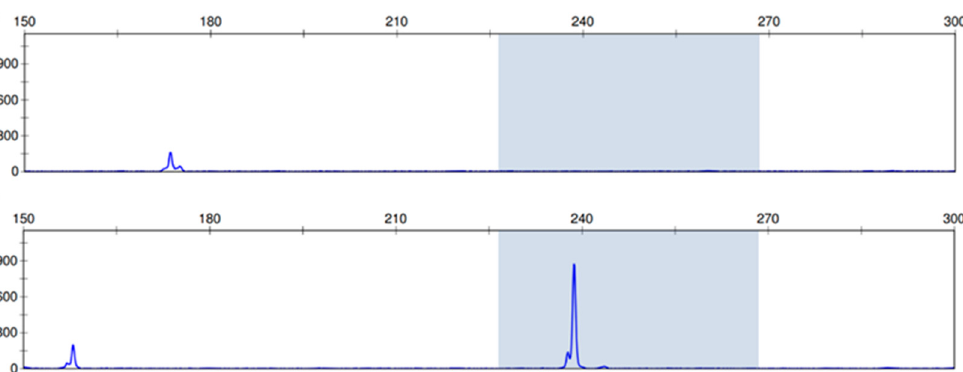
Figure 2. Criteria for fragment analysis. ( A ): Negative case, no peak at the expected fragment size of 228–268 bp ( B ): Positive case, a peak that is detected from the PCR product and represents a fragment size of 228–268